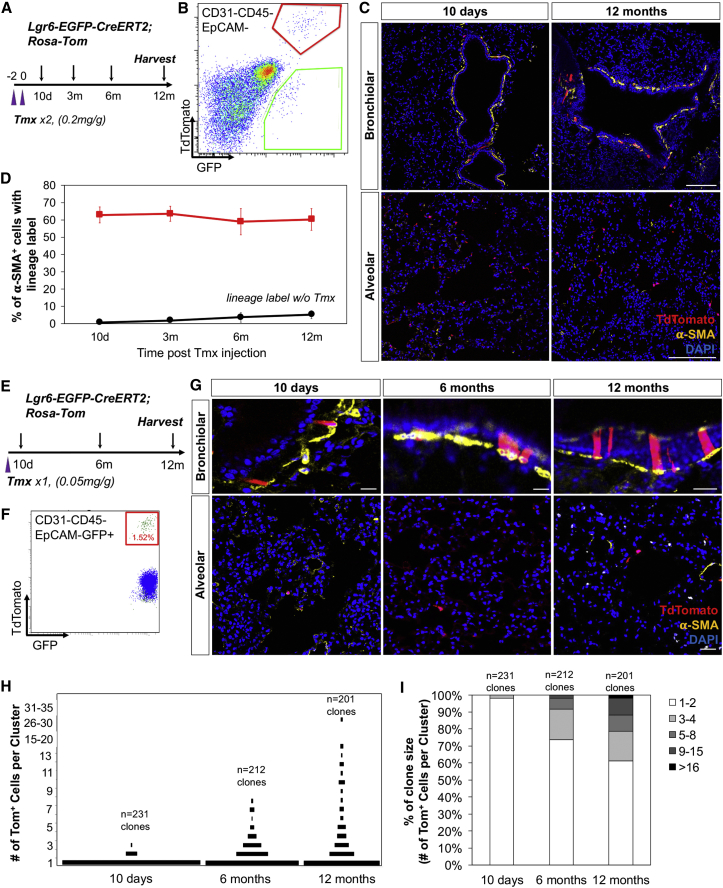
Proliferative Potential of Lineage-Labeled Lgr6+ Cells in Homeostatic Lungs(A and E) Schematics of the Lgr6-EGFP-CreERT2;R26-Tom lineage-tracing experiment.(B and F) Representative flow cytometry analysis showing the recombination efficiency of lineage-labeled Lgr6+ cells after Tmx induction.(C) Representative confocal images showing lineage-labeled Lgr6+ cells in adult lungs at 10 days and 12 months after Tmx induction: Tdtomato (red); α-SMA (yellow); and DAPI (blue).(D) Graphs to show the mean percentage of lineage-labeled Lgr6+ airway smooth muscle cells (ASMCs) following Tmx exposure (red circles). Control animals receive vehicle alone, and low recombination is seen without Tmx injection (black circles).(G) Representative confocal images showing proliferative expansions of lineage-labeled Lgr6+ cells in lung homeostasis: Tdtomato (red); α-SMA (yellow); and DAPI (blue).(H and I) Size distribution of clusters at indicated time points post-induction. Length of bar represents frequency in (H).n, number of clones scored. The scale bars represent 100 μm (C), 10 μm (G, top), and 50 μm (G, bottom).